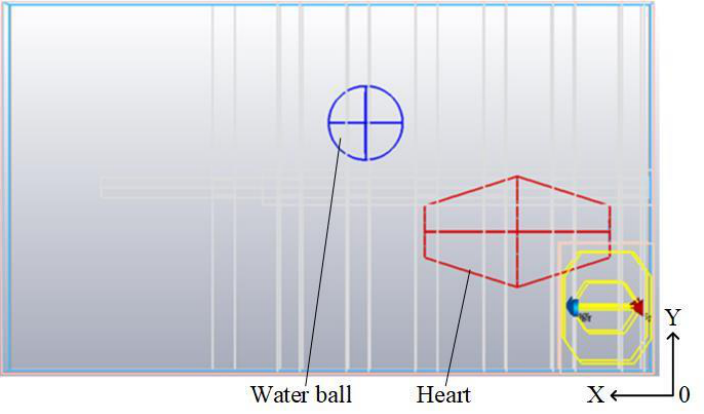
Fig. 3. Model of the chest area containing